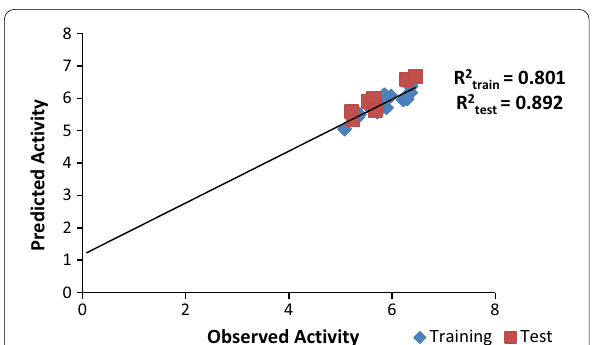
Fig. 1 Plot of predicted pIC 50 against experimental pIC 50 for training and test sets